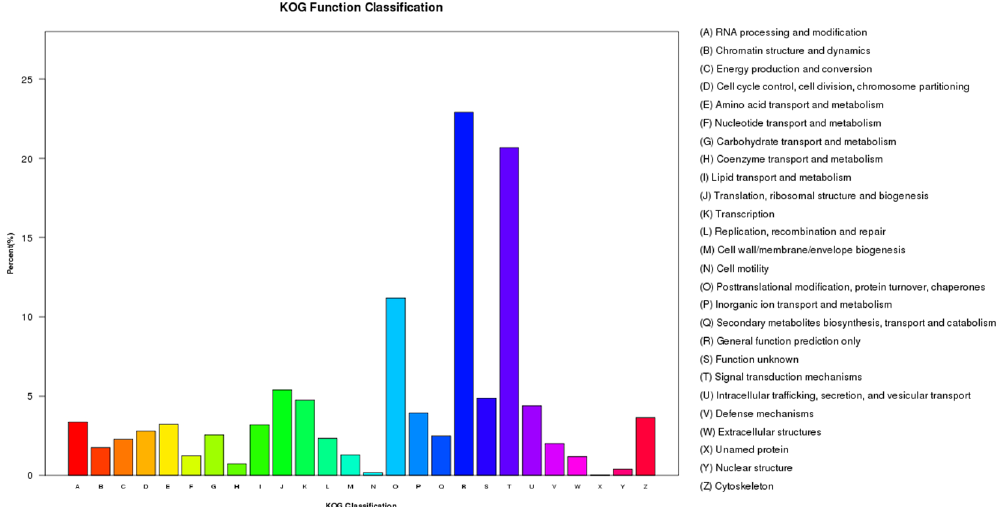
Figure 6. KOG (euKaryotic Ortholog Groups) classifications of putative proteins in the gill transcriptome of R. philippinarum